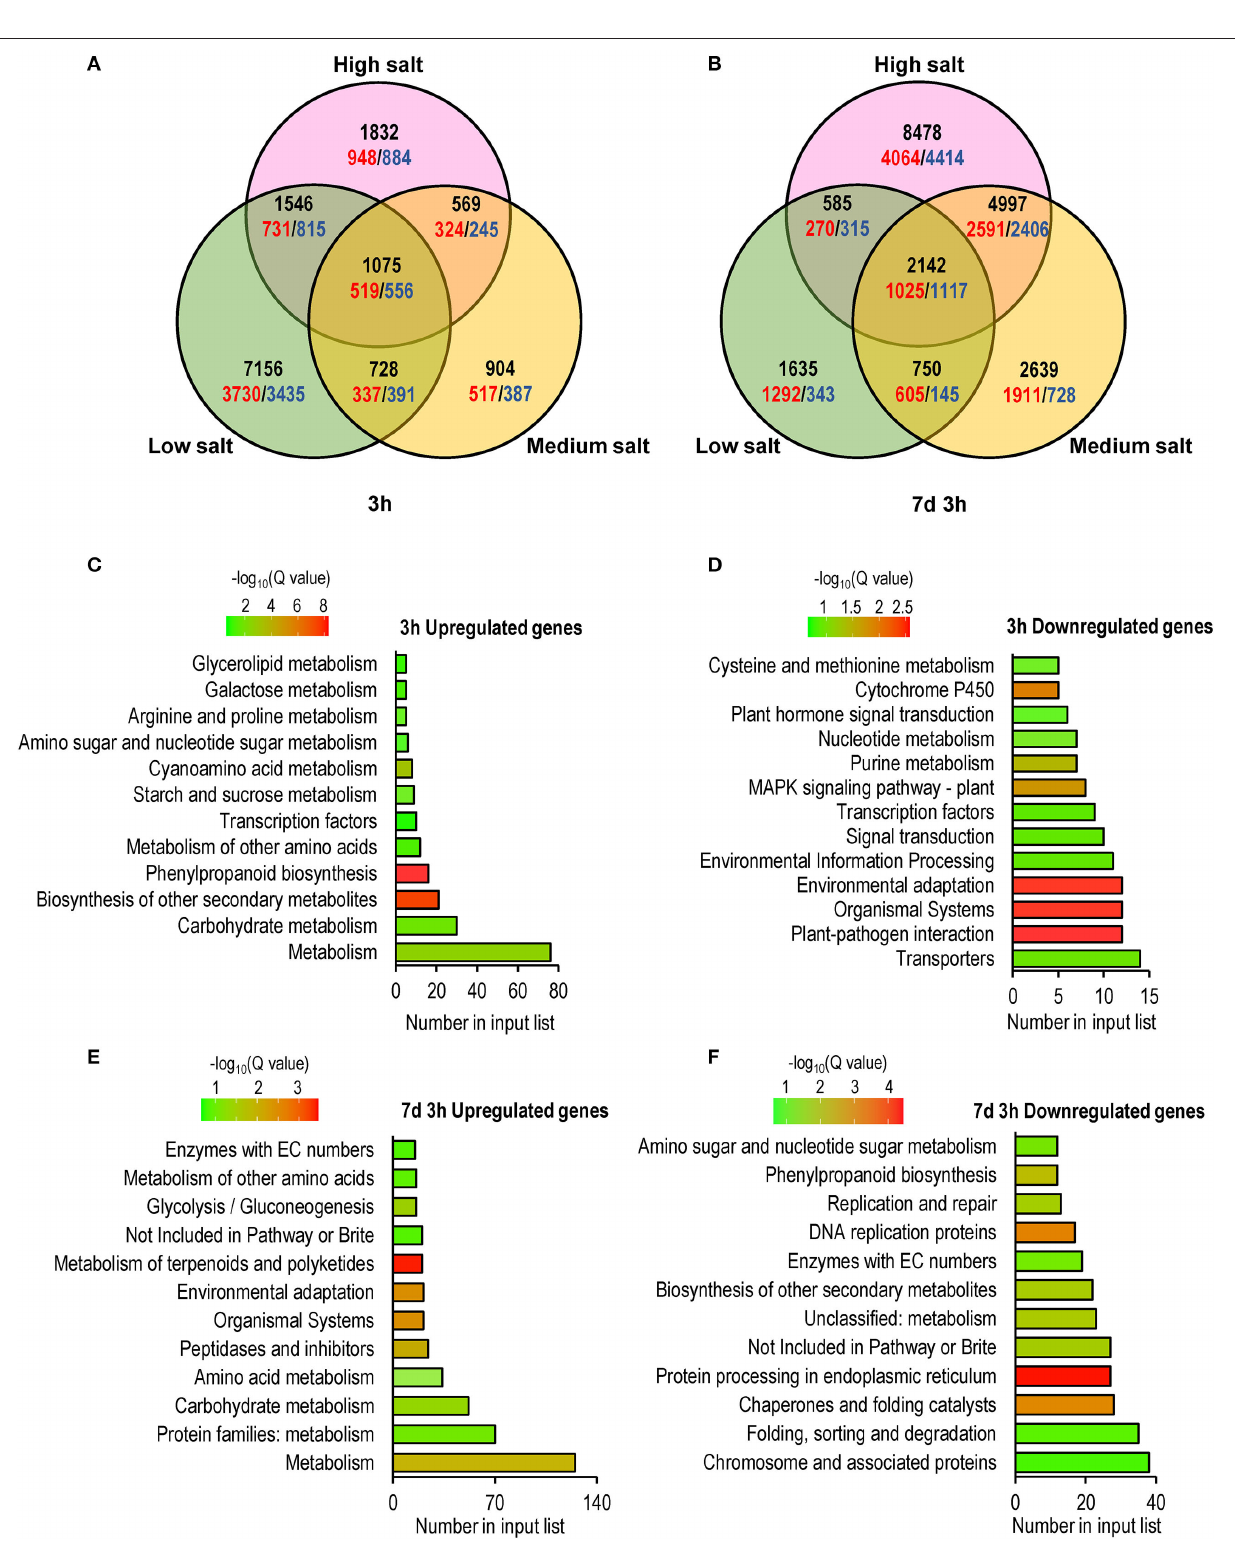
Frontiers in Plant Science | www.frontiersin.org